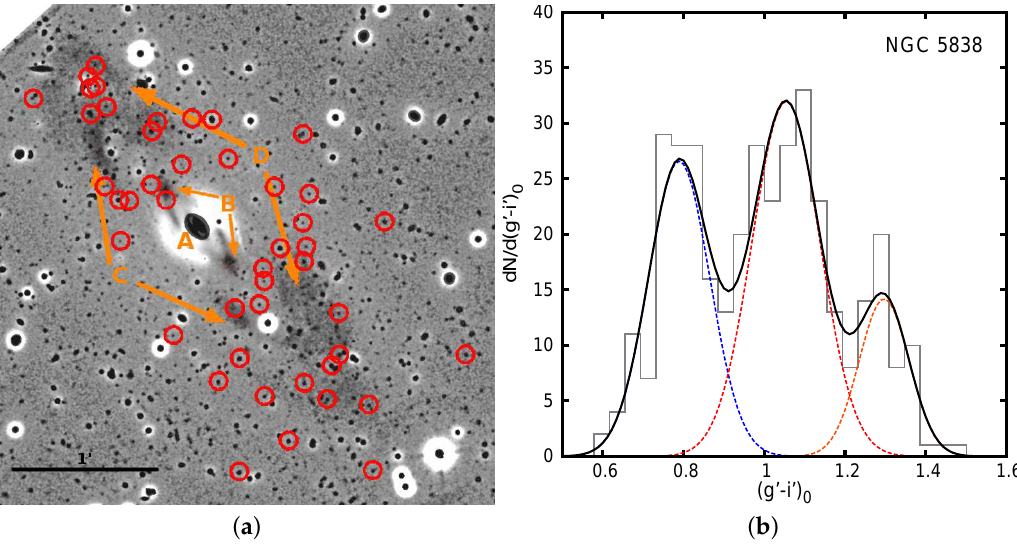
Figure 3. ( a ) Image after the galaxy light is removed. The orange letter A indicates the inner ring of dust. Letters B, C, and D show the outer stellar rings and/or the thin remains of a possible spiral structure. ( b ) Colour histogram ( g (cid:48) − i (cid:48) ) 0 for the GC candidates of NGC5838. The dashed lines show the Gaussian fit performed for each GC